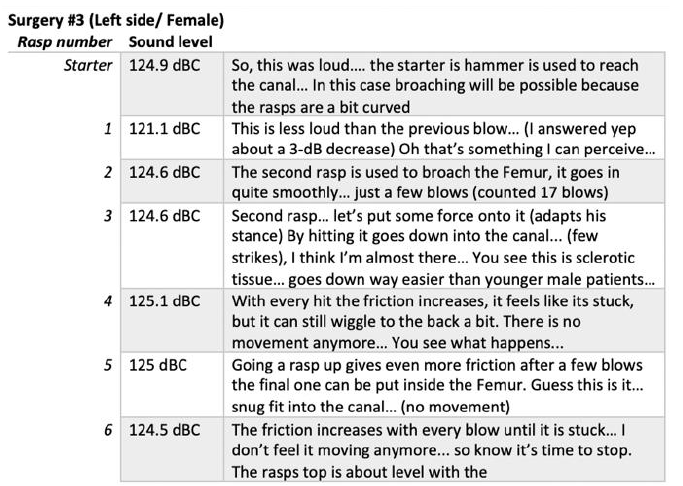
Figure 10. An excerpt of conversations (between the researcher and the surgeon) during the surgery demonstrating a surgeon’s awareness of the loudness of the hammer blow and the physical evidence with the dB(C) measurement that the second blow is measured to have a lower loudness level by 3.8 dB.